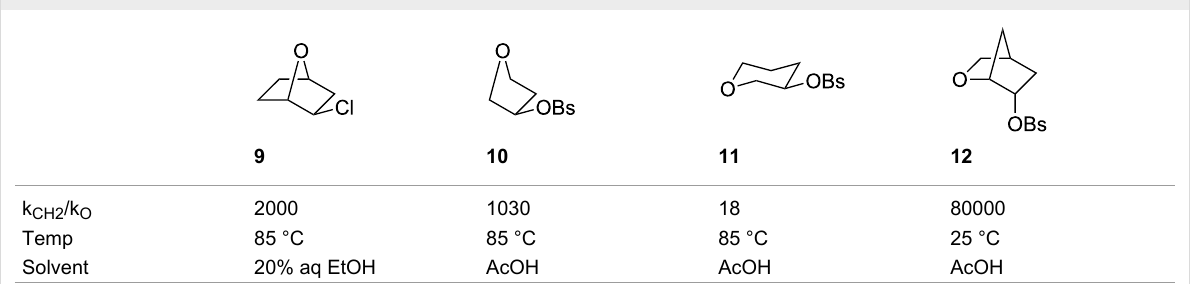
Table 2: Solvolysis reactions: oxygen substituent effects on reactivity a .